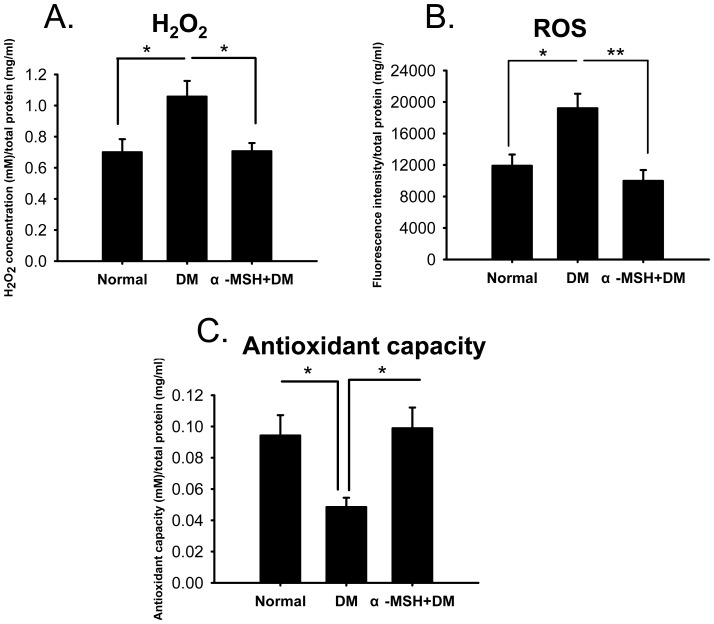
Intravitreal injections of α-MSH normalized the ROS levels and the total anti-oxidative abilities in early diabetic retinas.The levels of H2O2 (A) and ROS (B), and the total anti-oxidative abilities (C) were measured and normalized to total protein concentrations in the retina samples from experimental groups. n = 5–10/group, * p<0.05, ** p<0.01.